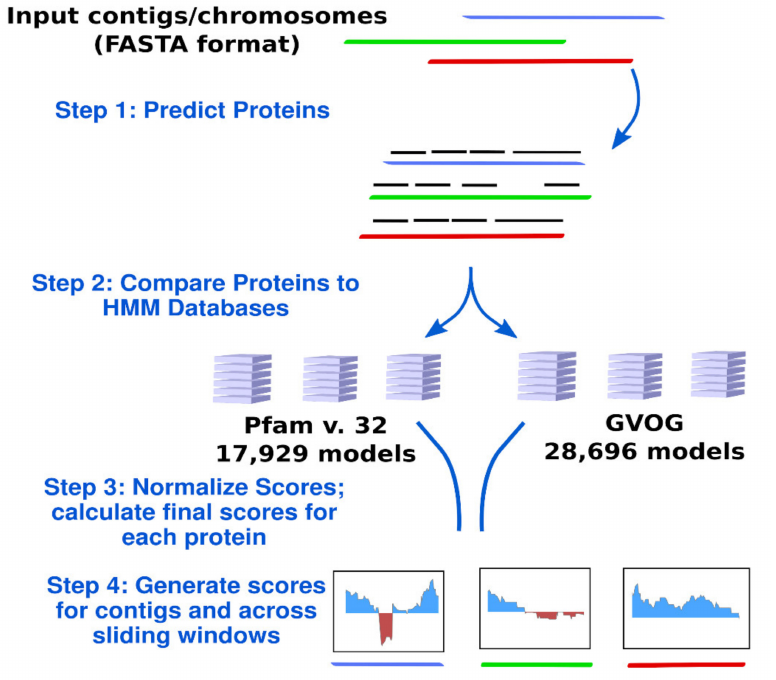
Figure 1. Diagram of the ViralRecall workflow. Abbreviations: GVOGs, giant virus ortholo- gous